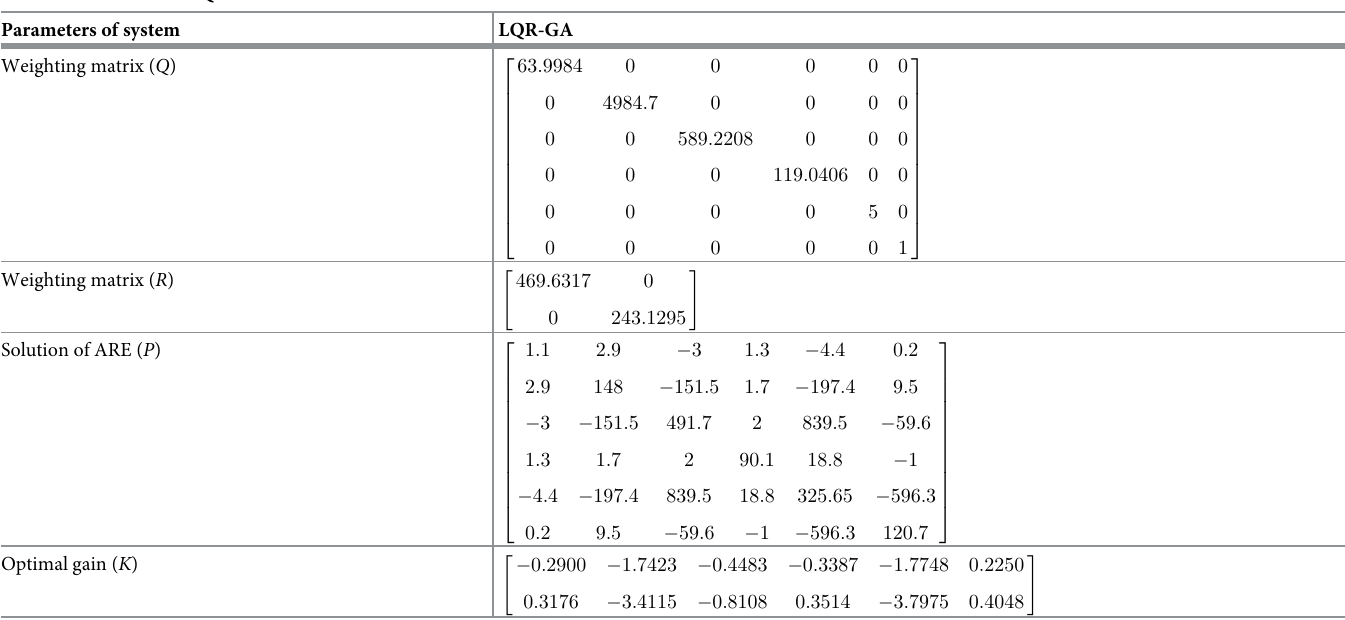
Table 3. The results of LQR based GA